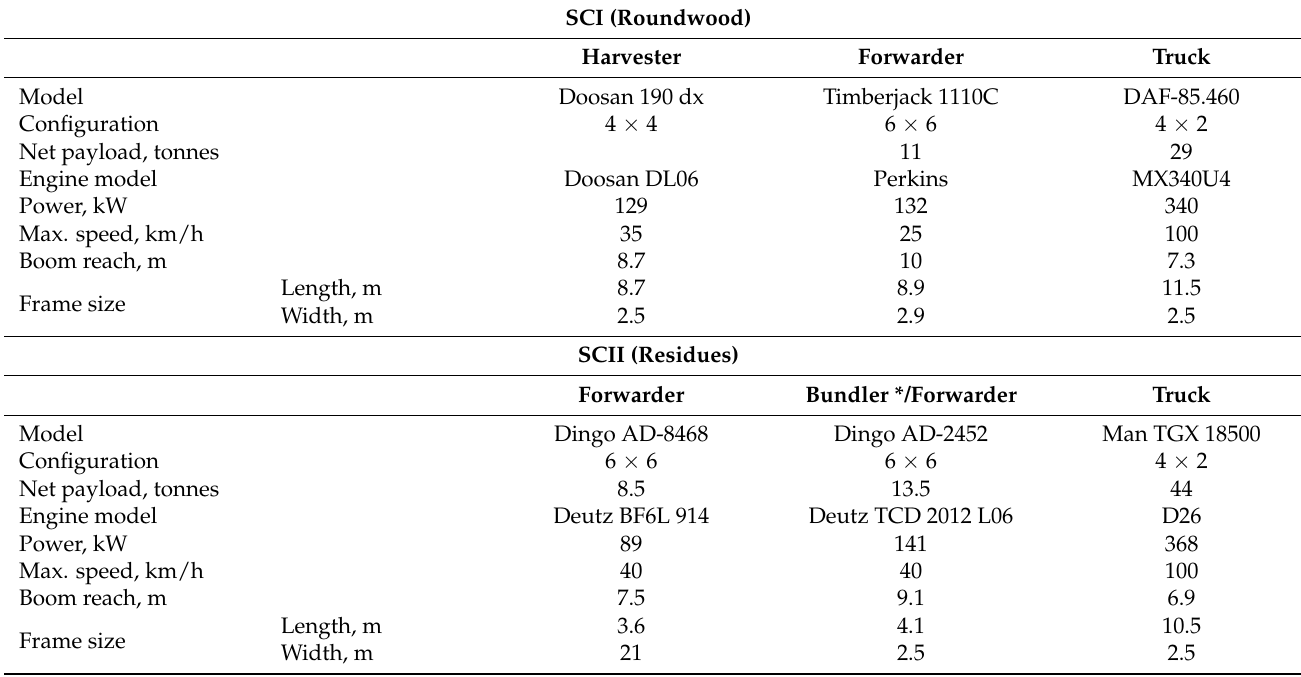
Table 2. Technical specifications of the machines in SCI and SCII included in the study.